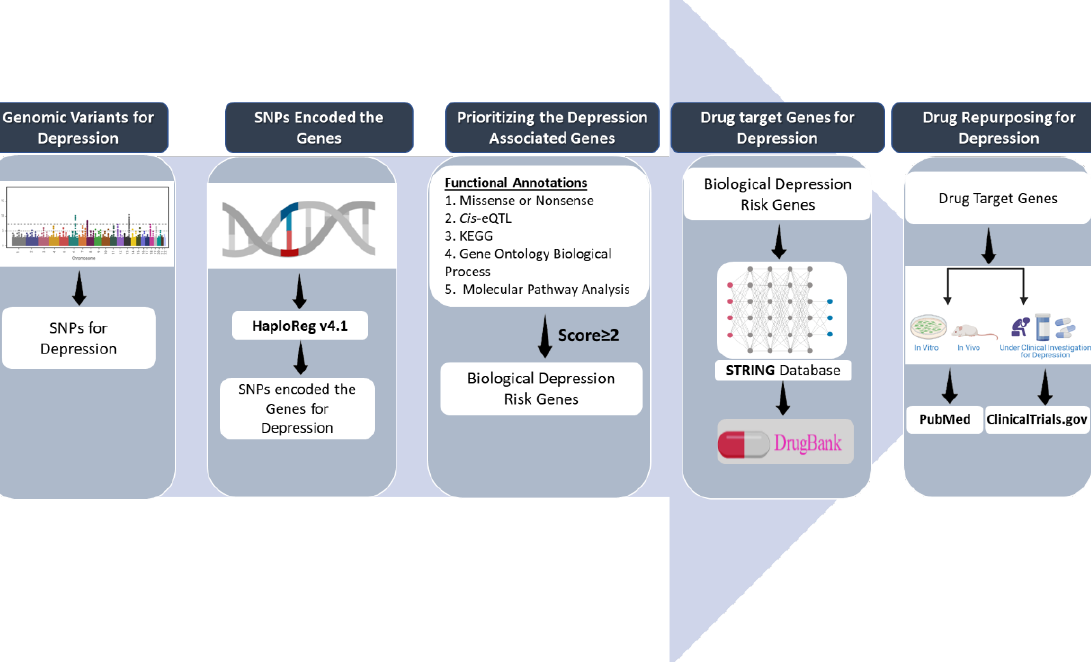
Figure 1. Overview of drug repurposing for depression. In this study design, SNPs were prioritized using a machine learning algorithm and various databases: HaploReg v4.1, STRING, DrugBank, ClinicalTrials.gov, and PubMed.